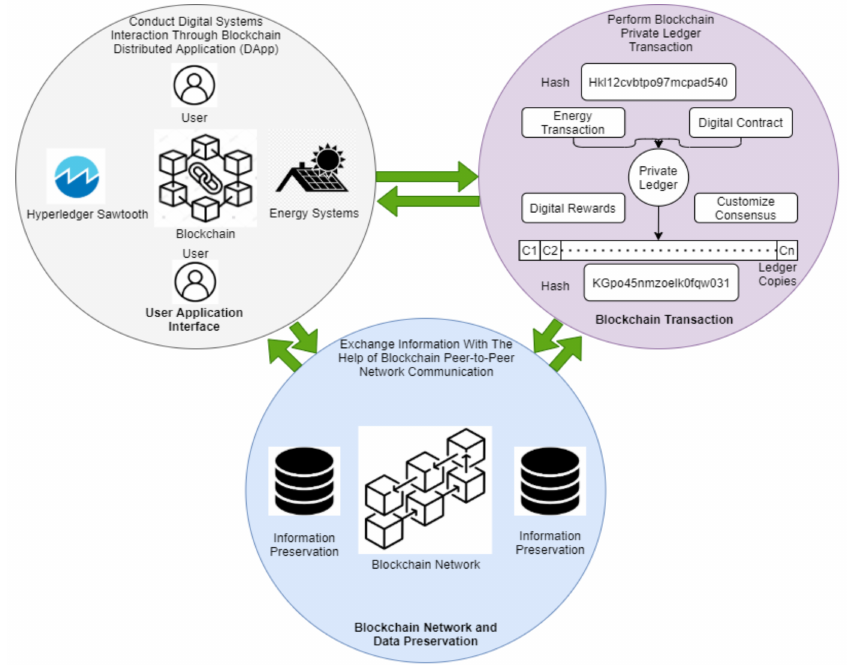
Figure 2. Blockchain Hyperledger Sawtooth-enabled secure EPS-ledger distributed node